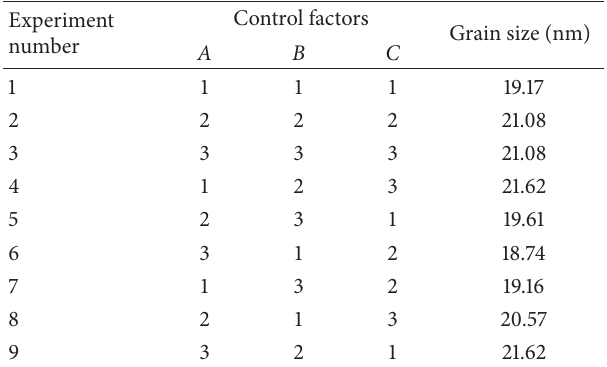
Table 2: Grain size of ZnO thin films for the L9 orthogonal array from experiments 1 ∼